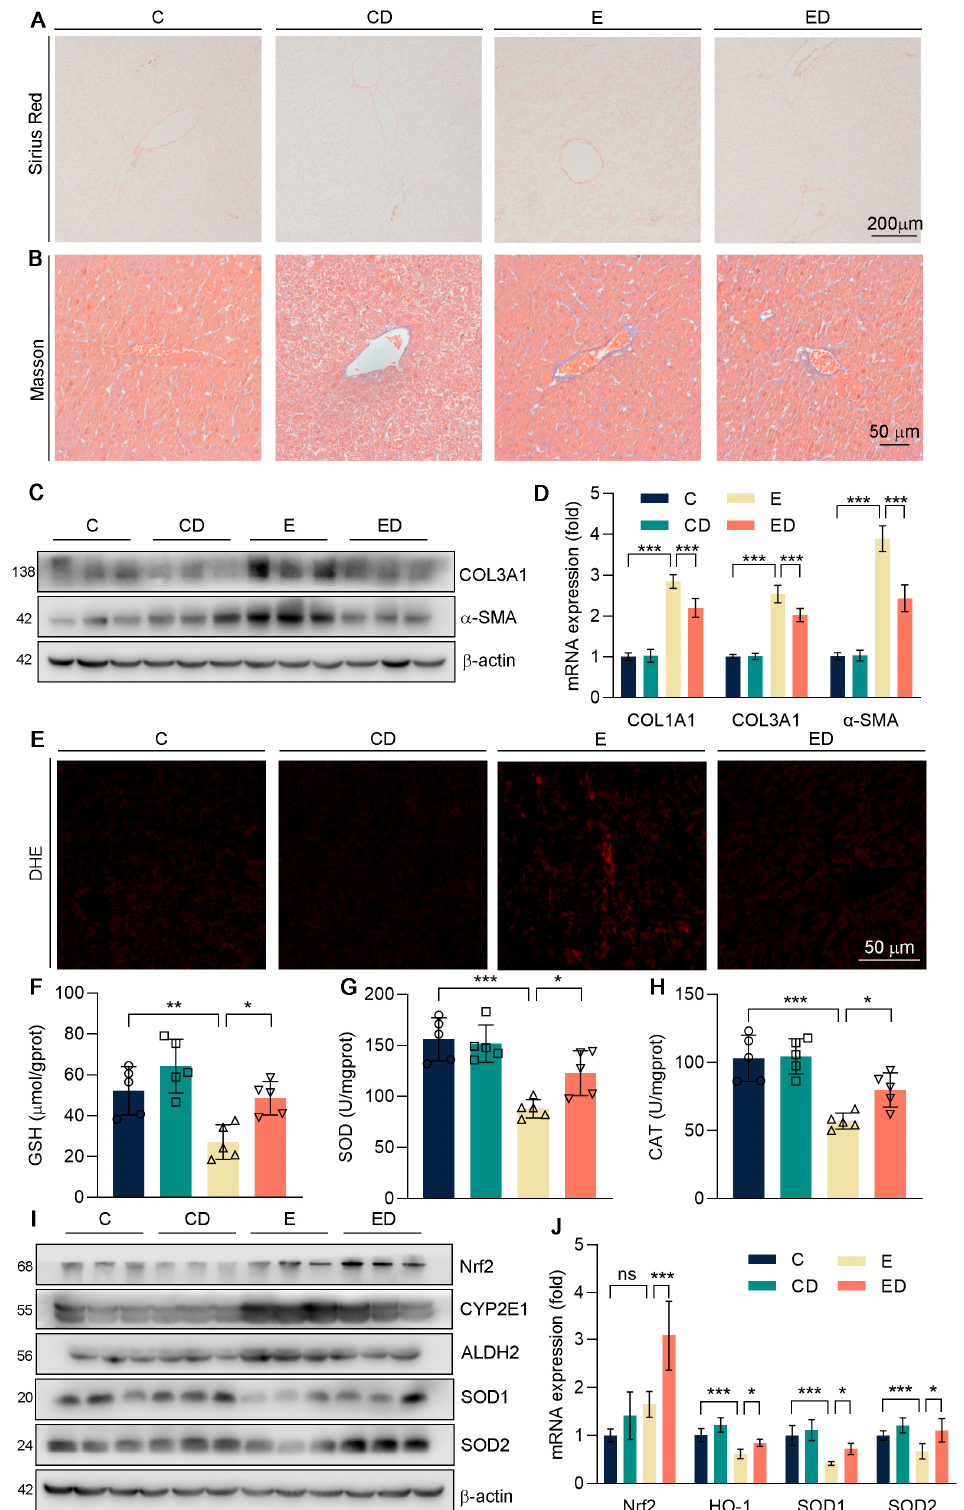
2 Figure 2. The effect of DAU on hepatic oxidative stress induced by alcohol. ( A ) Hepatic Picrosirius Red staining of mice. ( B ) Hepatic Masson staining of mice. ( C , D ) Protein and mRNA expression of COL1A1, COL3A1, and α − SMA in mice liver. ( E ) Hepatic DHE staining of mice. ( F – H ) Hepatic GSH, SOD, and CAT levels. ( I ) Protein expression of Nrf2, CYP2E1, ALDH2, SOD1, and SOD2 in mice liver. ( J ) mRNA expression of Nrf2, HO − 1, SOD1, and SOD2 in mice liver. Data are mean ± SD using one − way ANOVA ( n ≥ 3), * p < 0.05, ** p < 0.01, *** p < 0.001, ns: not